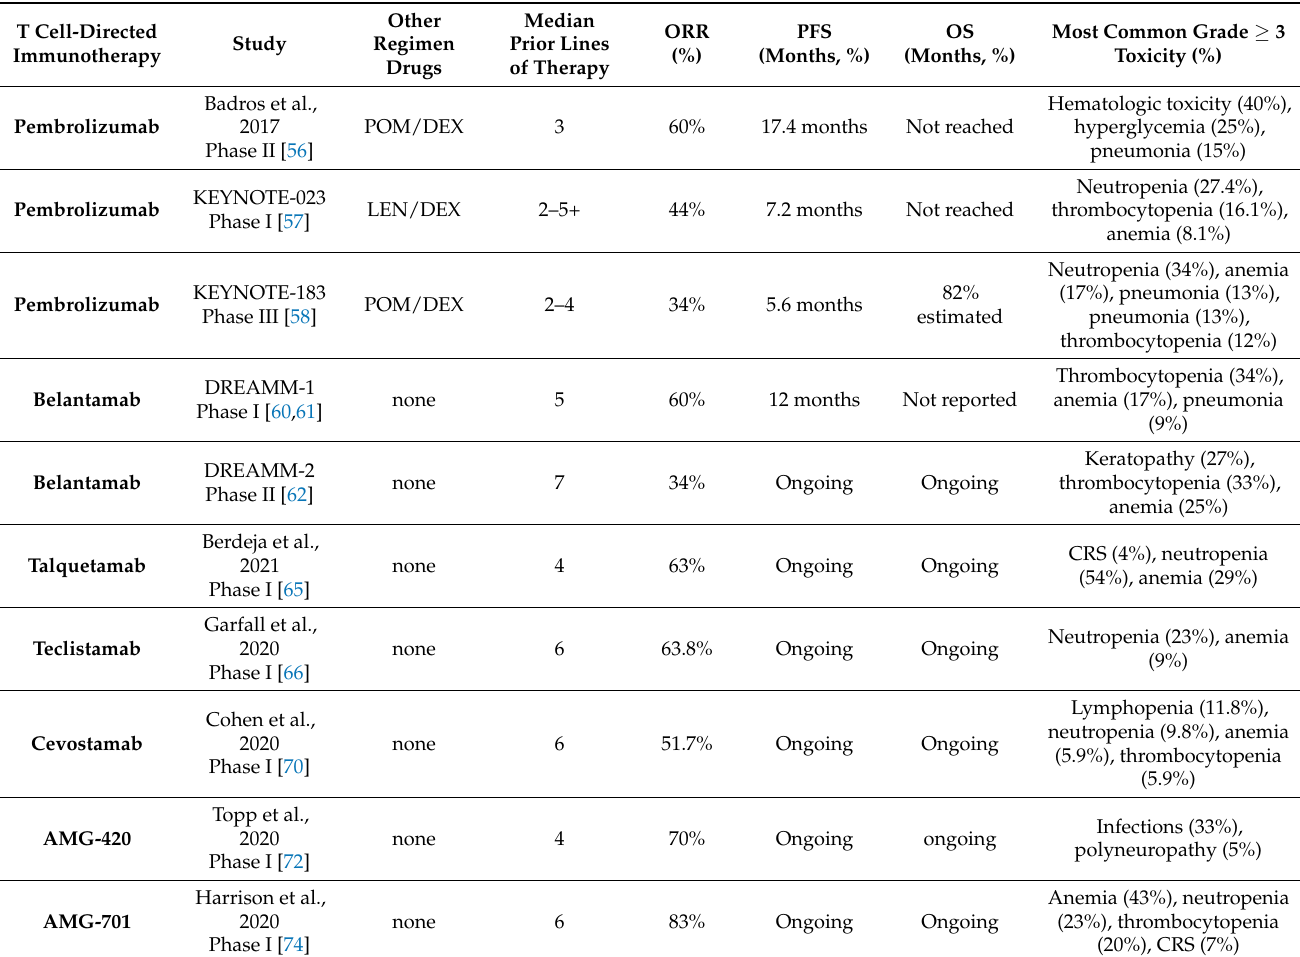
Table 4. T cell-directed immunotherapy clinical trial results in relapsed or refractory multiple